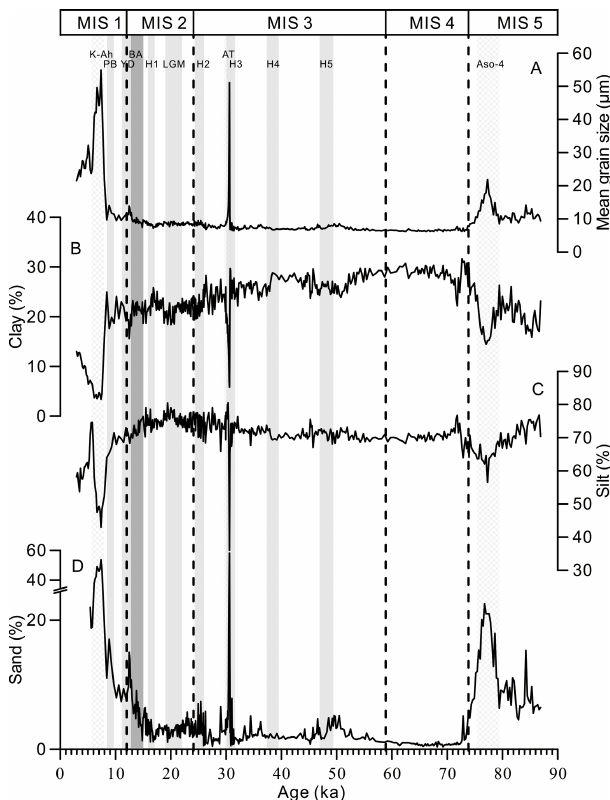
Figure 4. Time series plots for contents of sand, silt and clay and the mean grain size. Gray bars indicate the intervals of impor- tant climatic events. MIS 1, 2, 3, 4 and 5 represent marine iso- tope stages. K-Ah, AT and Aso-4 refer to well-known ash layers, recorded across a wide spread of the Sea of Japan and the northern Okinawa Trough and indicated by the gray bars filled with diagonal cross. PB, YD, BA, H1, H2, LGM, H3, H4 and H5 refer to Prebo- real, Younger Dryas, Bølling–Allerød, Heinrich 1, Heinrich 2, Last Glacial Maximum, Heinrich 3, Heinrich 4 and Heinrich 5, respec-